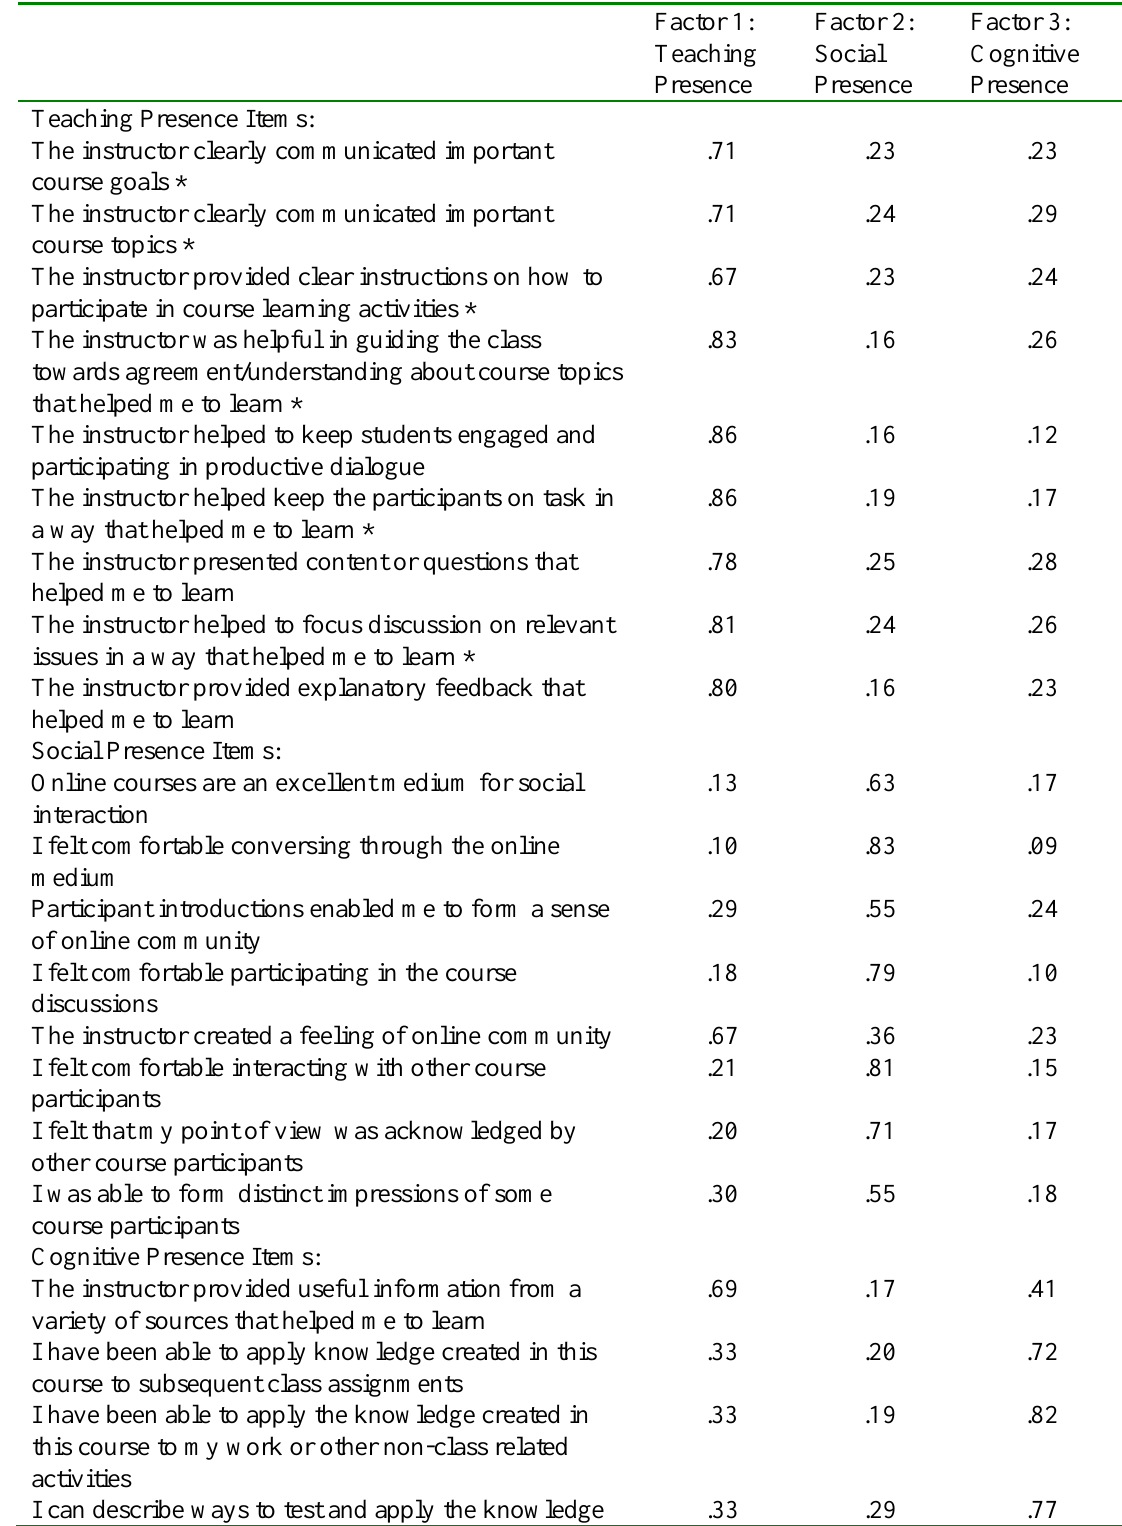
Table 1 . Factor loadings for CoI survey items (N =